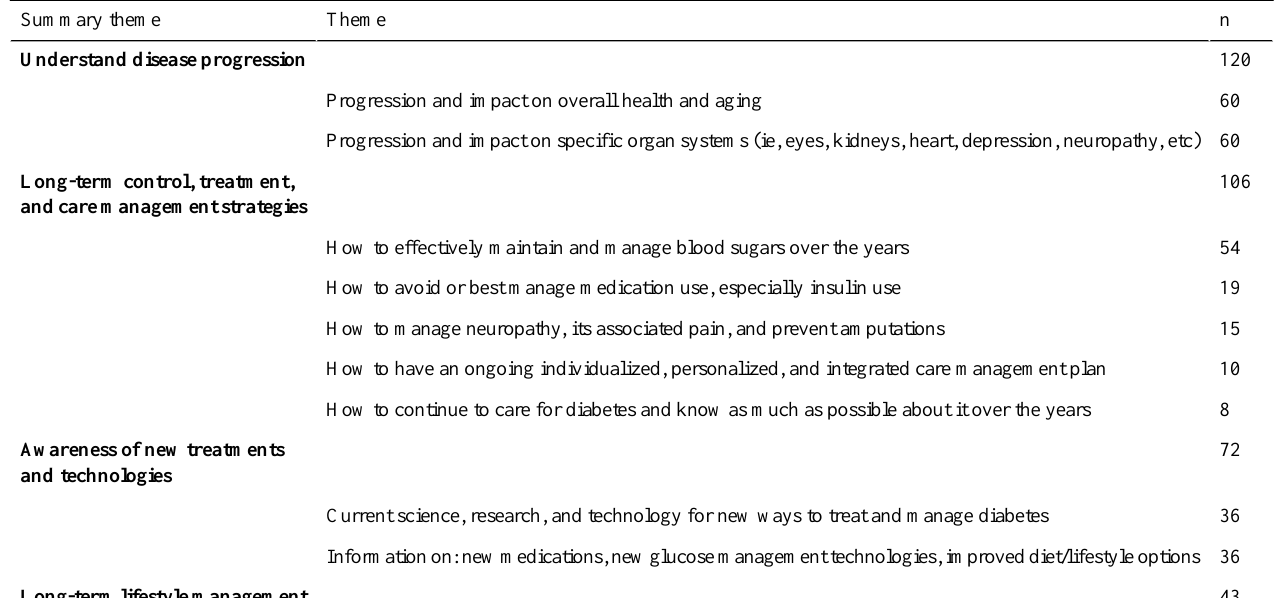
Table 4. Summary themes for responses to the question, “Thinking about 3-5 years into the future from now, what do you feel will be important to learn or know about your diabetes? Why?” (n=283).